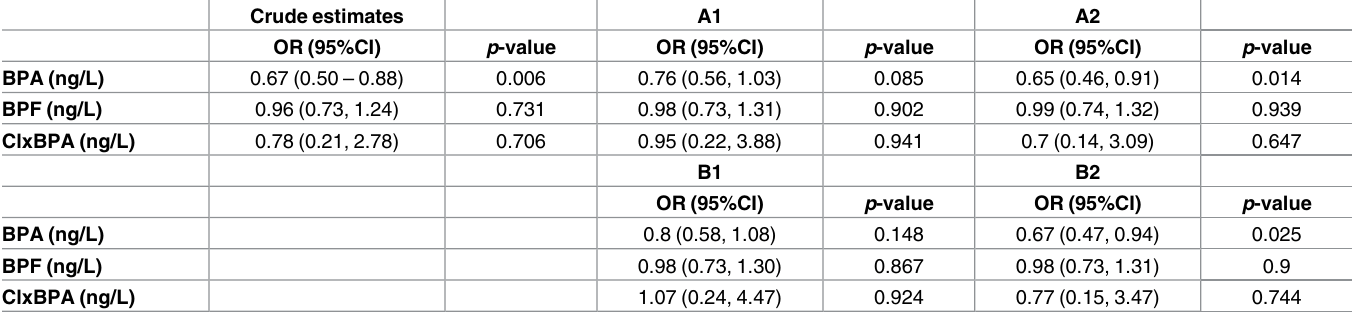
Table 3. Odds ratios of having thyroid nodules and urinary BPF, BPA and ClxBPA adjusted for age, BMI, hormone levels (A1) and iodine (B1). The two sets of models were repeated with the inclusionof the study site as a covariate (A2, B2).